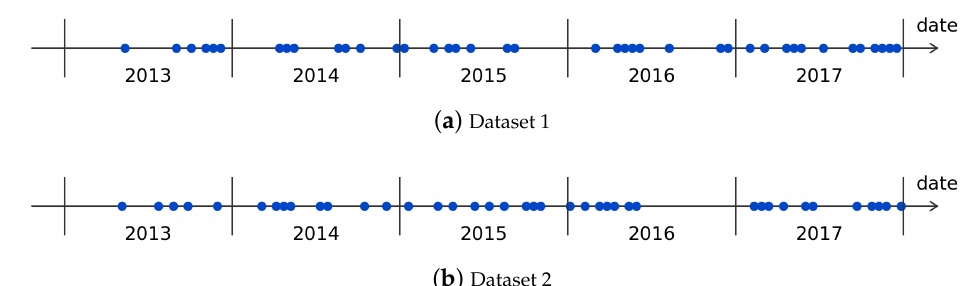
Figure 6. Temporal distributions of images in the two SITS